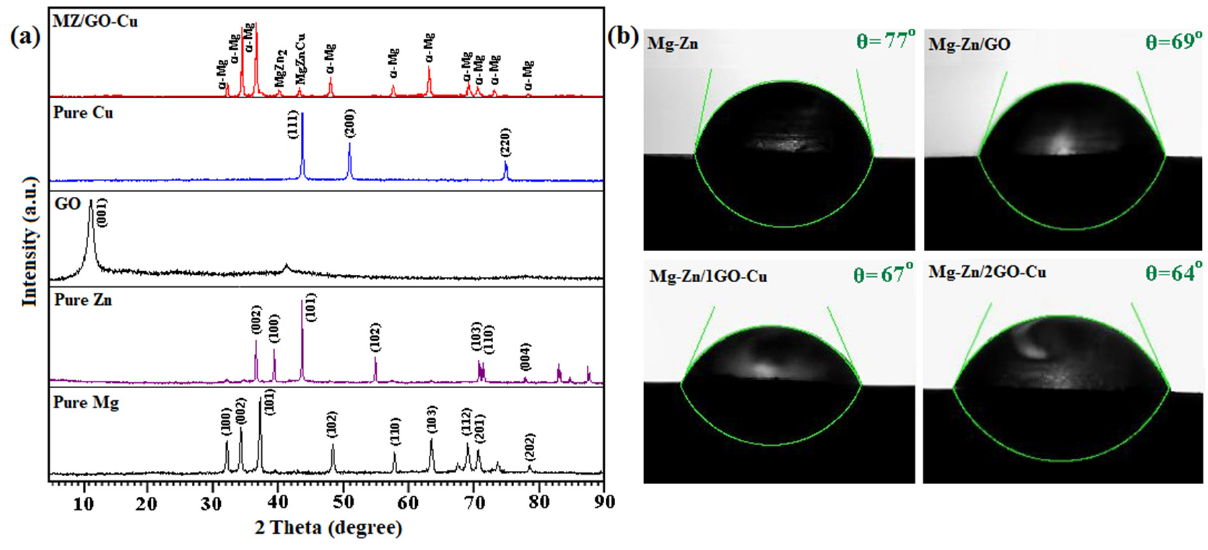
Figure 5. ( a ) XRD pattern and ( b ) Contact angle of MZ, MZ/GO, MZ/1GO-Cu and MZ/2GO-Cu composites after SPS process.